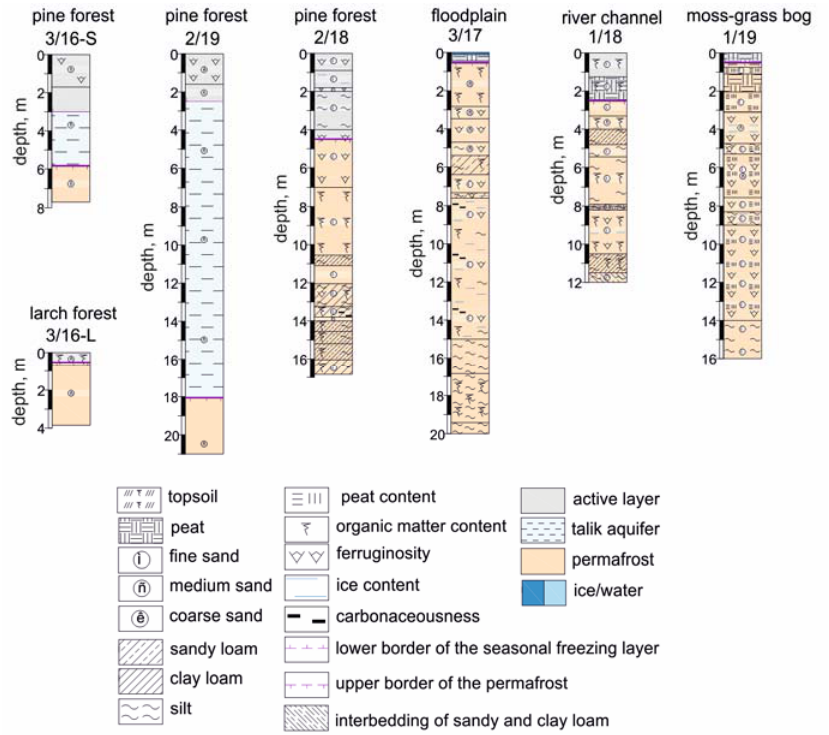
Figure 3. Geological sections of seven boreholes, located in talik area (3/16-S, 2/19) and in permafrost from the surface area (all other boreholes).